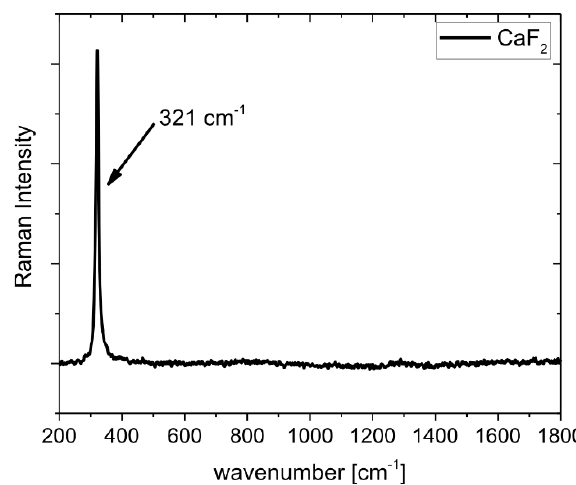
Figure 10. Raman spectrum of CaF 2 .